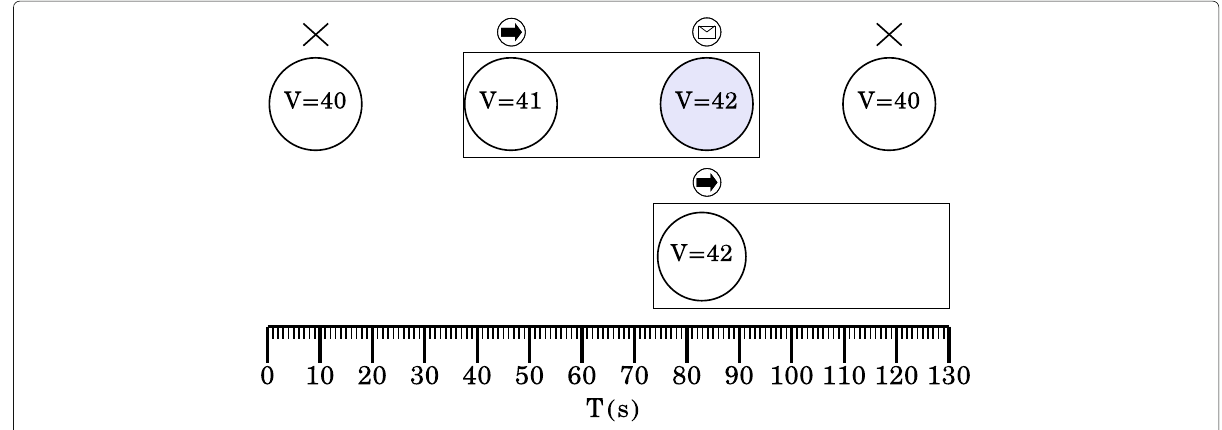
Fig. 7 Simulation for the Generation of Events, Type Closer-Context Events, with CEP Pattern on a Time